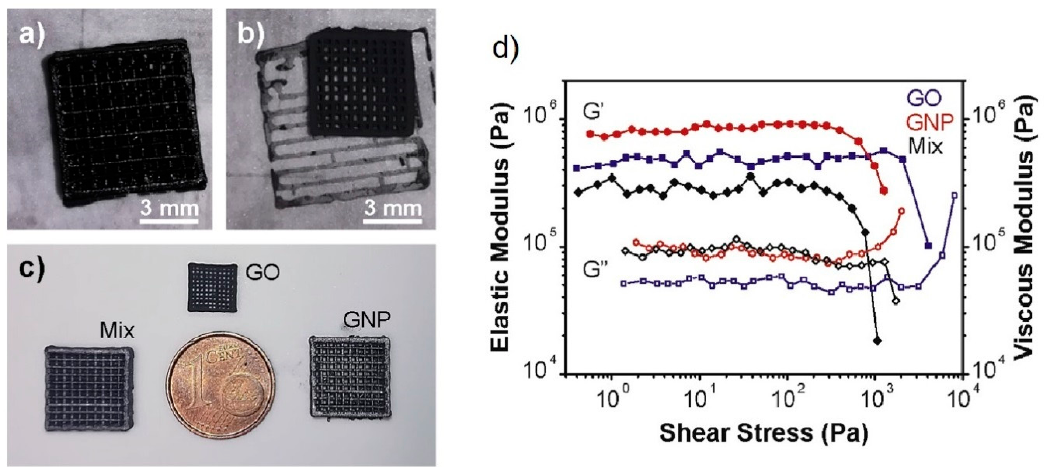
Figure 18. ( a ) Patterned structure used for scaffolds designing and ( b ) scheme of the contact area between two orthogonal rods, where h , a , and Ø correspond to the distance between two equivalent layers in the z direction, the distance between two adjacent rods, and the rod diameter, respectively. ( c ) Apparent viscosity as a function of the shear rate for the GNPs/SiC pastes formulated with 0, 5, 10 and 20 vol% GNPs in the powder compositions. ( d ) View of a 10 vol% GNPs/SiC sintered scaffold. Reproduced from [208], with permission from Elsevier, 2016.